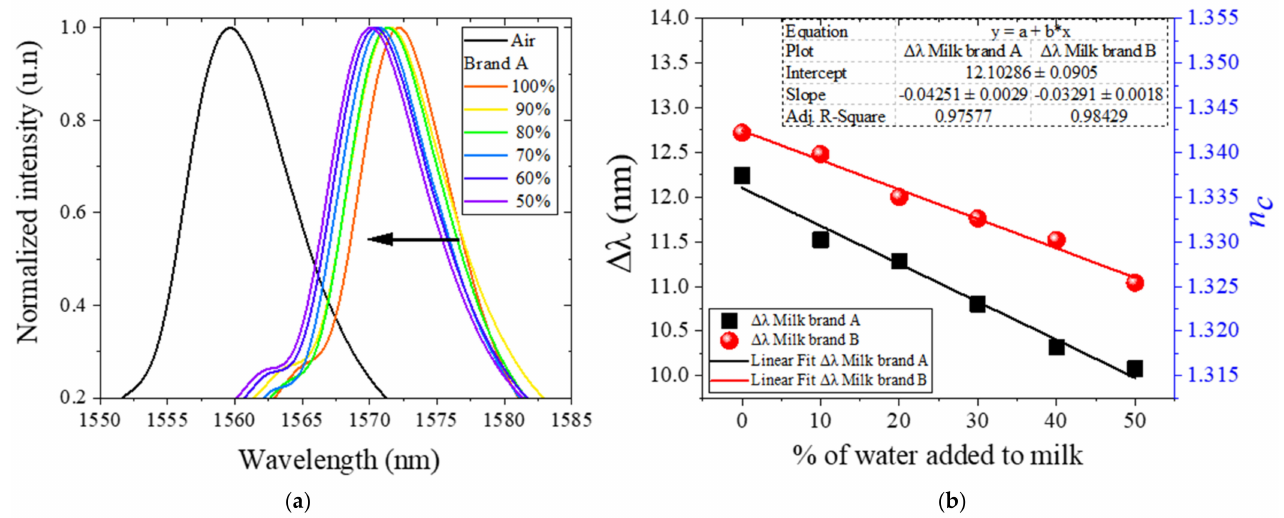
Figure 4. ( a ) Spectral response of the MMI sensor for water-adulterated blends for brand A. For reference, the spectral response at the baseline condition (when the sensor is in the air) is also plotted. ( b ) The spectral shift of the peak wavelength, with respect to the baseline condition, as a function of the amount of water added to the sample, for the two brands